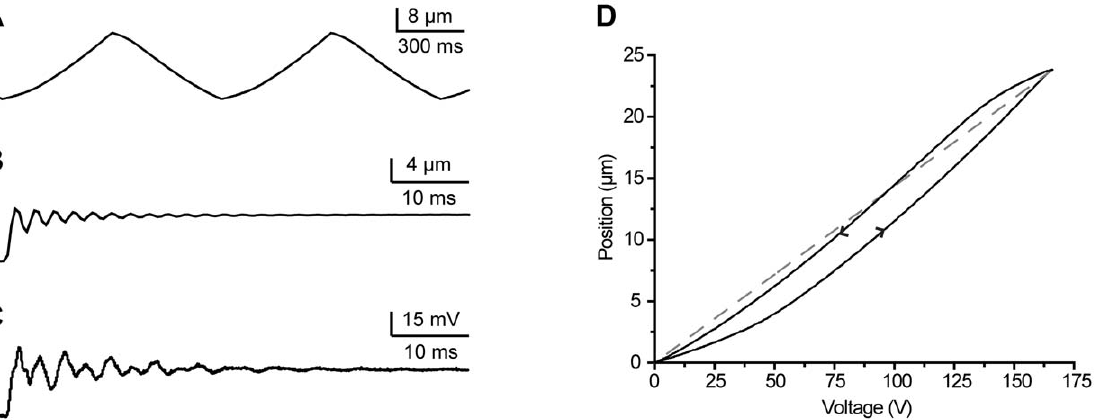
Figure 5. Dynamical system characterization. A, Actuator movement response to a triangle wave control signal. B, Actuator displacement in the z-axis in response to a square wave control pulse. C, Sensor resonance in response to a square wave probe tip displacement. D, Actuator hysteresis determined from A; dashed line represents an ideal case with no hysteresis. doi:10.1371/journal.pone.0042733.g005 PLOS ONE |